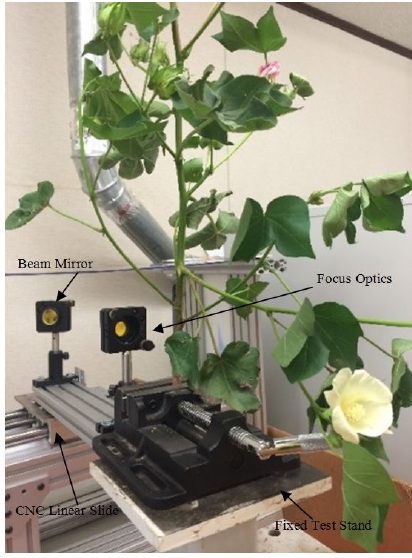
Figure 5. Experimental micro-controller based CNC CO 2 laser treatment system designed to provide precise control over the laser treatment time and energy density.